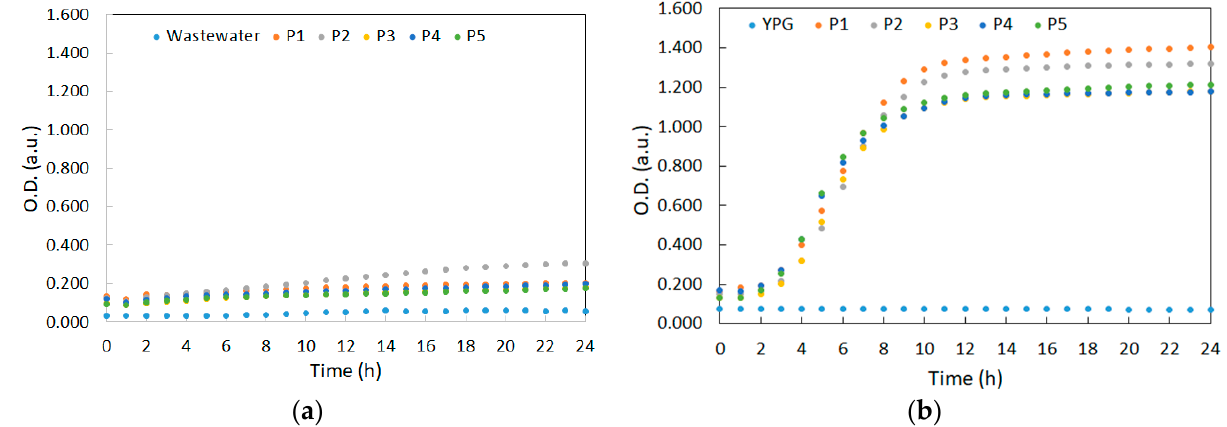
Figure 1. Growth curve of yeast strains in the absence of heavy metals: ( a ) in synthetic wastewater; ( b ) in YPG culture medium.